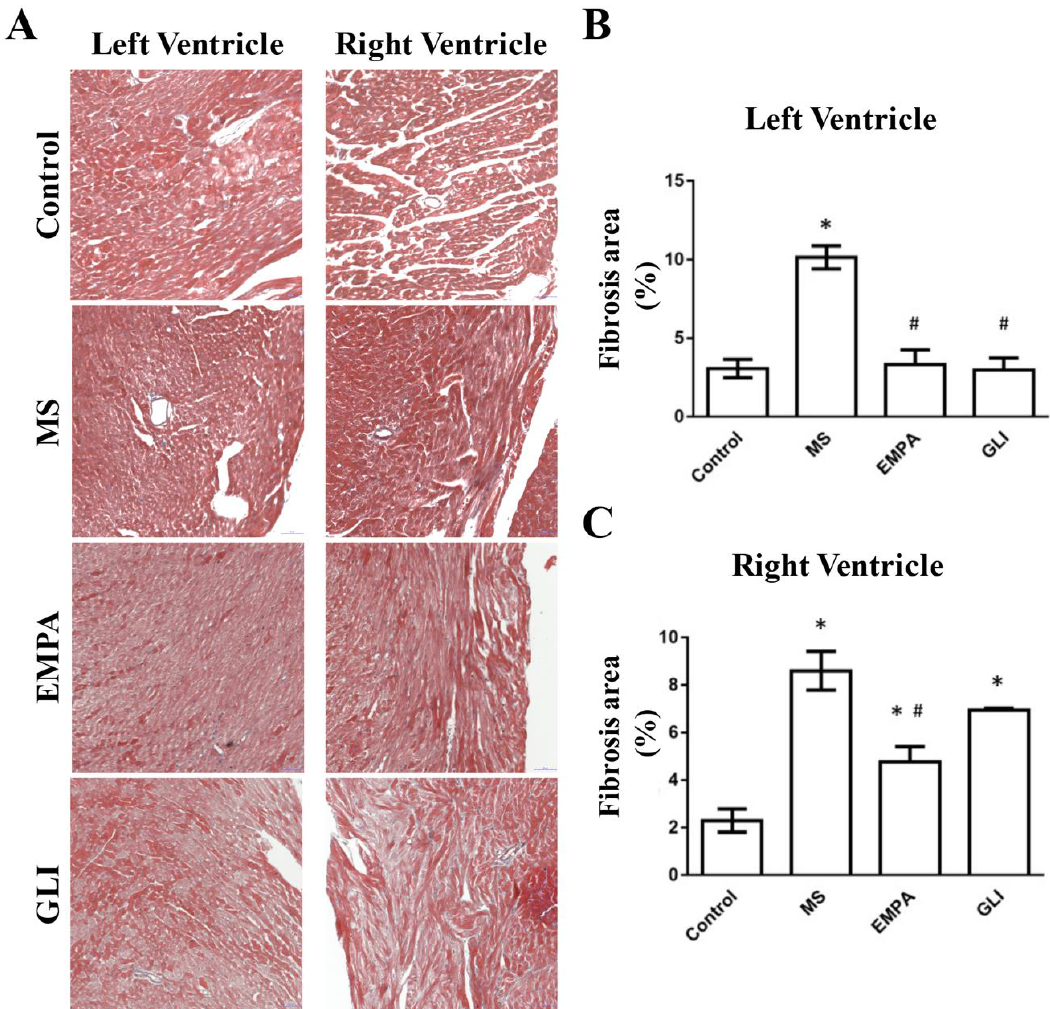
Figure 5. ( A ) Histological fibrotic images of ventricles among the study groups ( n = 5 for each group) as determined by Mason’s trichrome staining. Bar graphs of fibrotic areas in ventricles. ( B ) In the LV, the fibrotic areas in the MS were significantly increased compared with that in the control group. The fibrotic areas of the EMPA and GLI groups were significantly fewer than those in the MS group. (C ) In the RV, the fibrotic areas in the MS, EMPA, and GLI groups were increased compared with those in the control group. The fibrotic areas in the EMPA group were still significantly fewer than those in the MS group. *: p < 0.05 compared with the control group; #: p < 0.05 compared with the MS group.